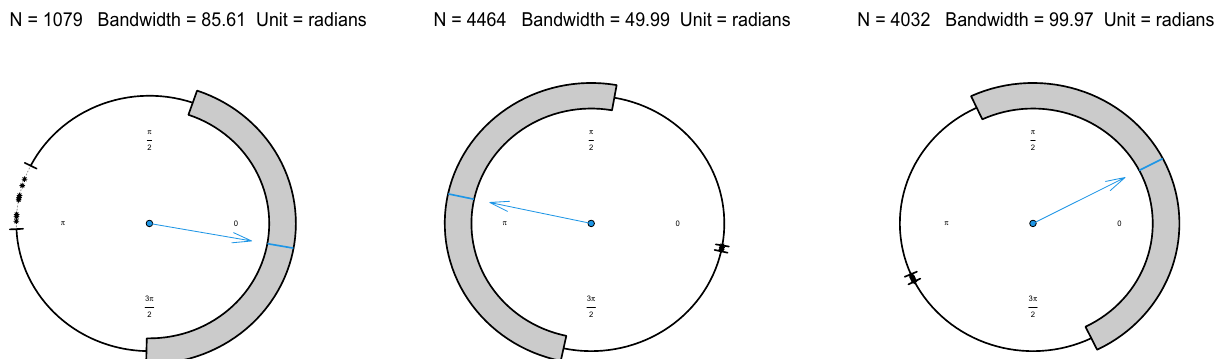
N = 4464 Bandwidth = 49.99 Unit =